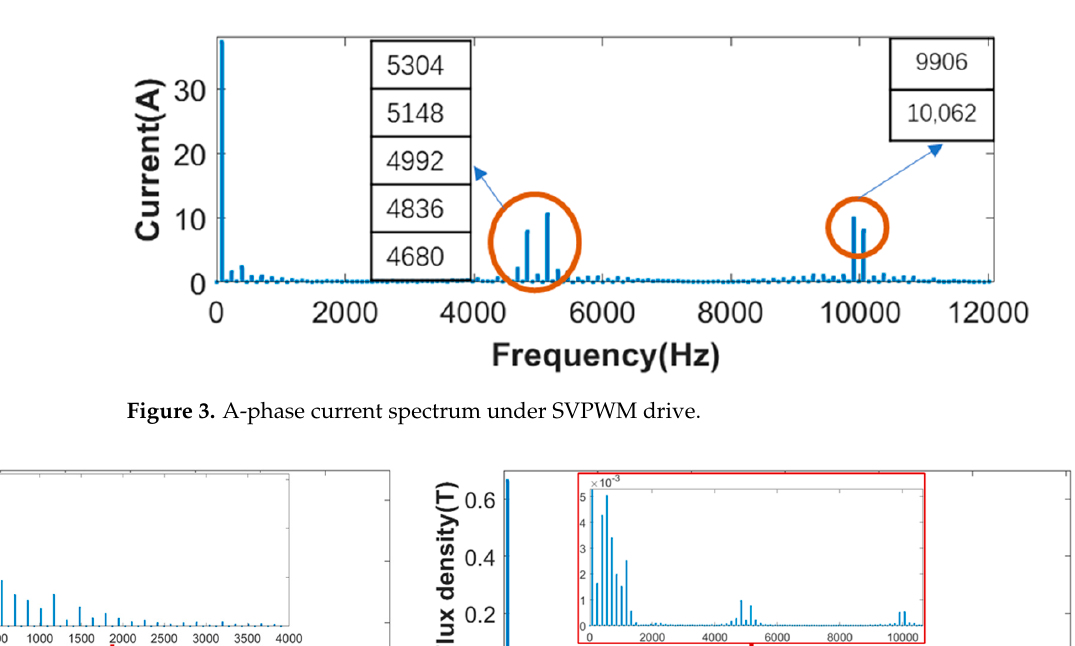
Figure 2. Simulation model of motor.